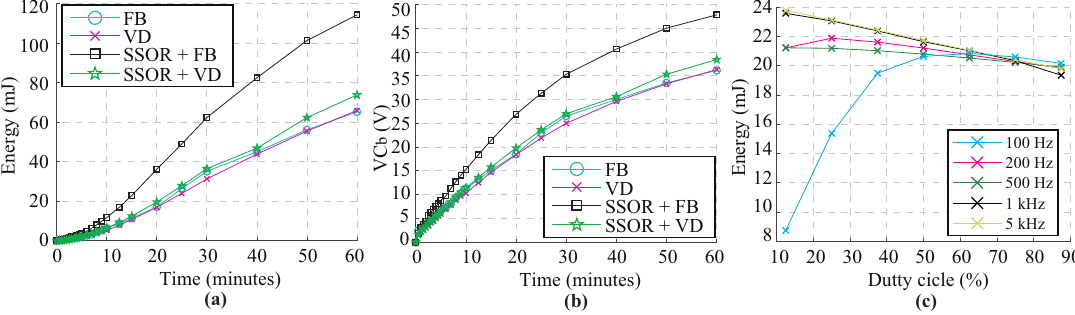
Figure 7. SSOR; ( a ) gathered energy in C b ; ( b ) charging pattern of C b , changing management circuit (Length: 1 m), under the open-circuit conditions; ( c ) charging pattern of C b according to the switching frequency (Length: 1 m), under the open-circuit conditions. Table 2. Comparison between proposed management circuits: Maximum power available and maximum output